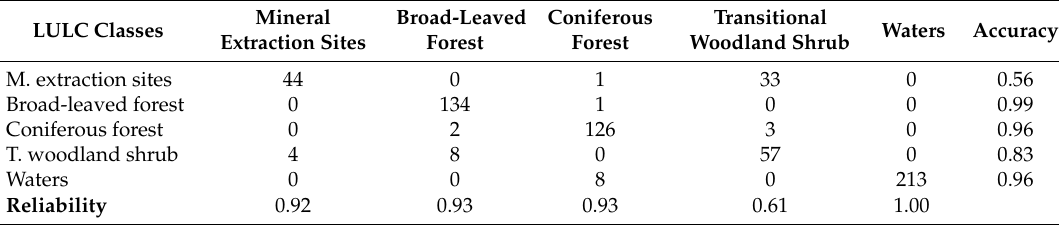
Figure 6. Jezi ó rko LULC classes—results of the Sentinel-2 image classification. Figure 6. Jeziórko LULC classes − results of the Sentinel-2 image classification. Table 2. Accuracy assessment for the Jezi ó rko area—confusion Table 2. Accuracy assessment for the Jeziórko area − confusion matrix.